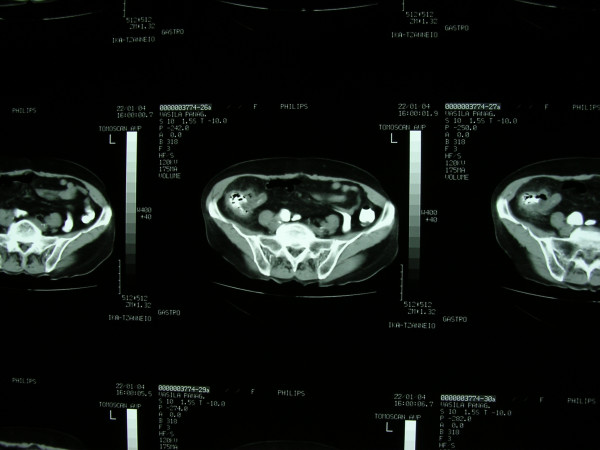
In abdominal CT scan a large inflammatory tumor like mass is identified. The characteristics of the mass do not indicate colon actinomycosis. The characters of the lesion and the coexisting edema and the severe and diffuse inflammation of the mesentery in the lower right quadrant probably suggest perforated ascending colon tumor.